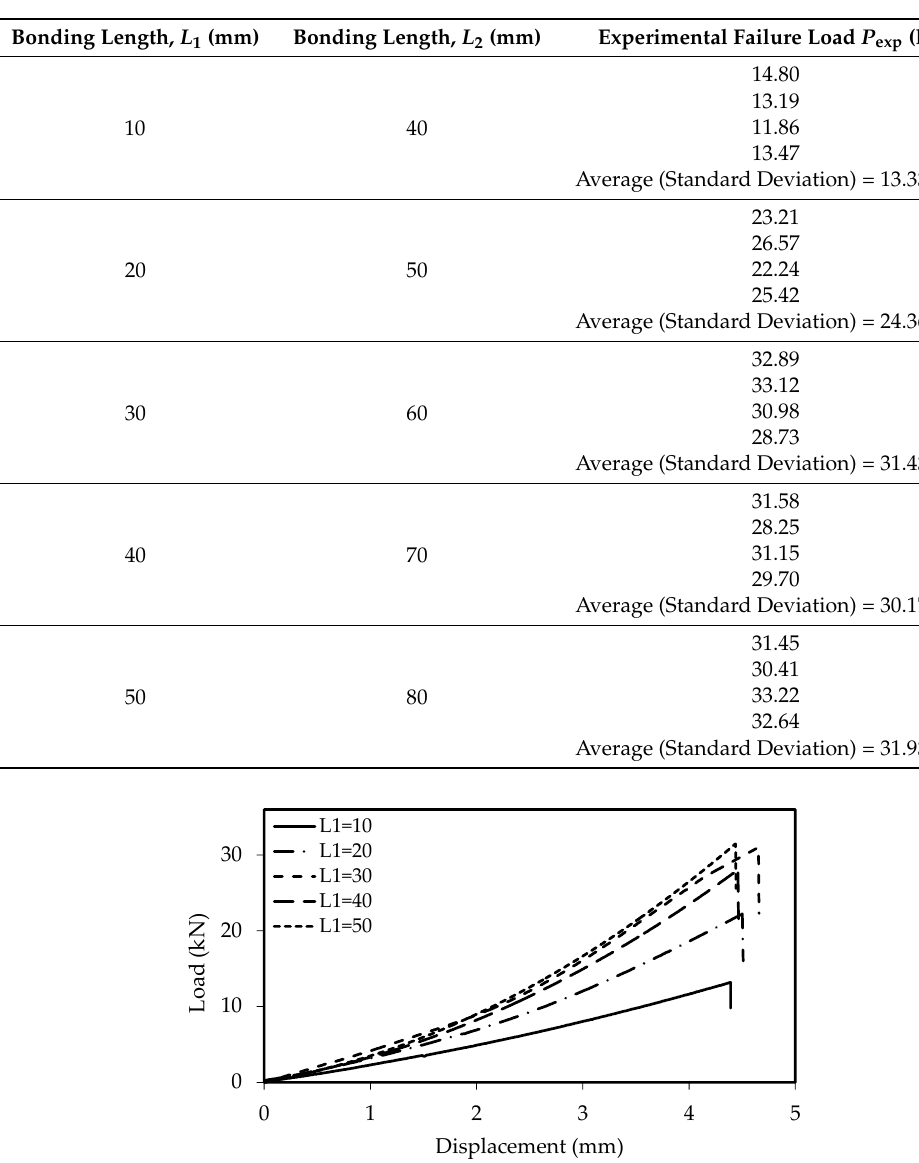
Figure 3. A sample load–displacement curve for the steel/CFRP DSJs under tensile quasi-static loading.